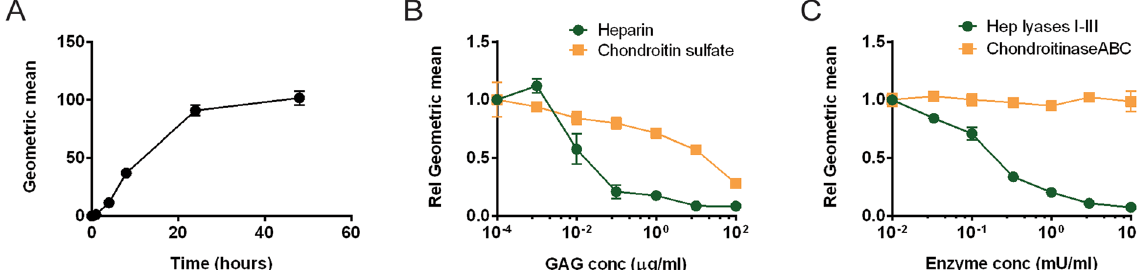
Figure 4. Internalization of α -synuclein amyloid fibrils in B103 cells depends on heparan sulfate. Alpha- synuclein fibrils labeled with pHrodo were added to B103 cells and internalization was measured by flow cytometry. ( A ) Time course of internalization of pHrodo- α -synuclein fibrils in B103 cells. ( B , C ) Cellular internalization of pHrodo- α -synuclein fibrils was determined after 8 hr of incubation (B) Dose-response curves when heparin or chondroitin sulfate was added to the cell media before addition of pHrodo- α -synuclein fibrils.